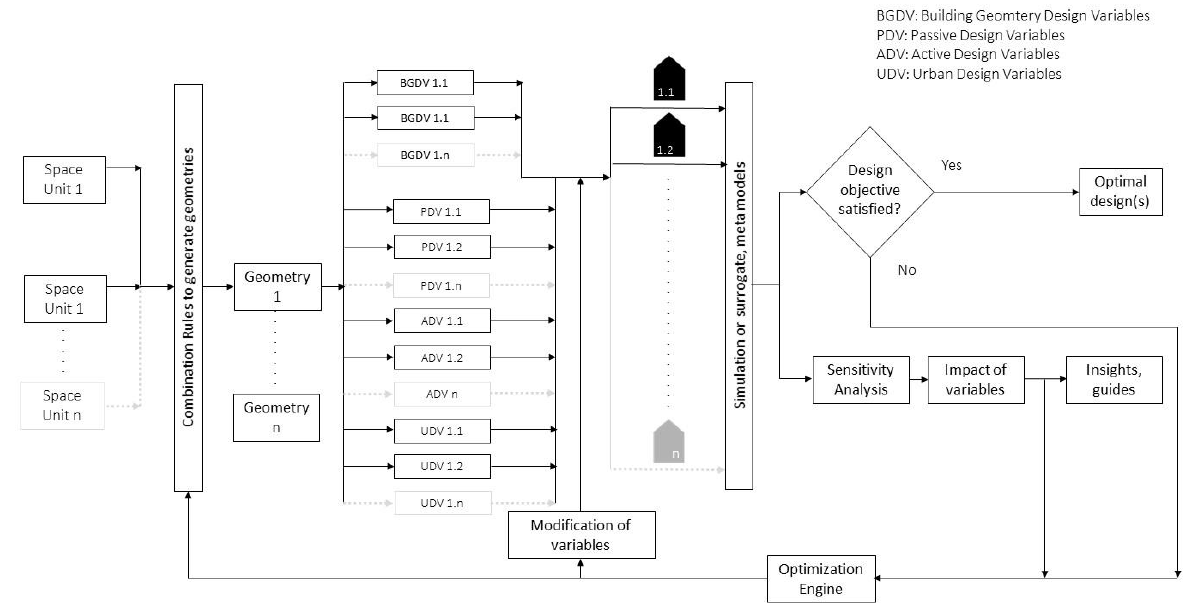
Figure 5. Flowchart of the basic principle of building shape generation methodology in BECEDO